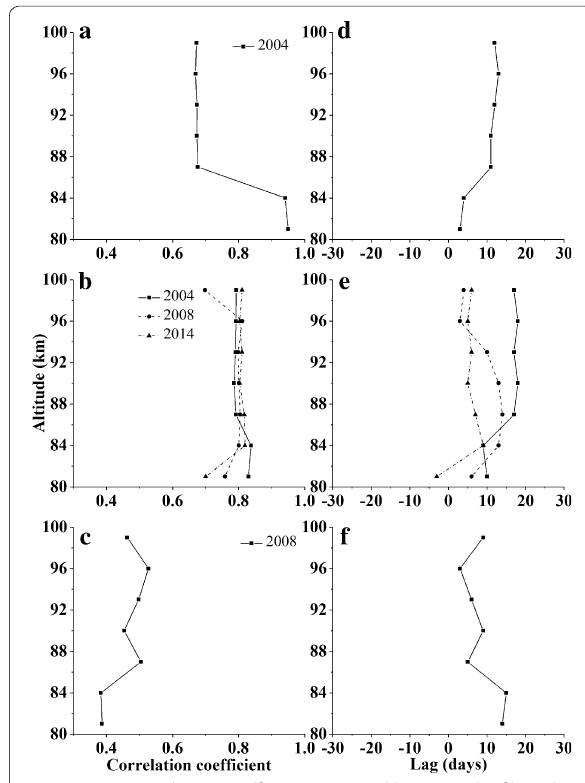
Fig. 5 Cross-correlation coefficient estimated between the filtered solar flux and zonal diurnal tide amplitude at ( a ) CA, ( b ) CP and ( c ) SM. Cross-correlation lags are shown at ( d ) CA, ( e ) CP and ( f )